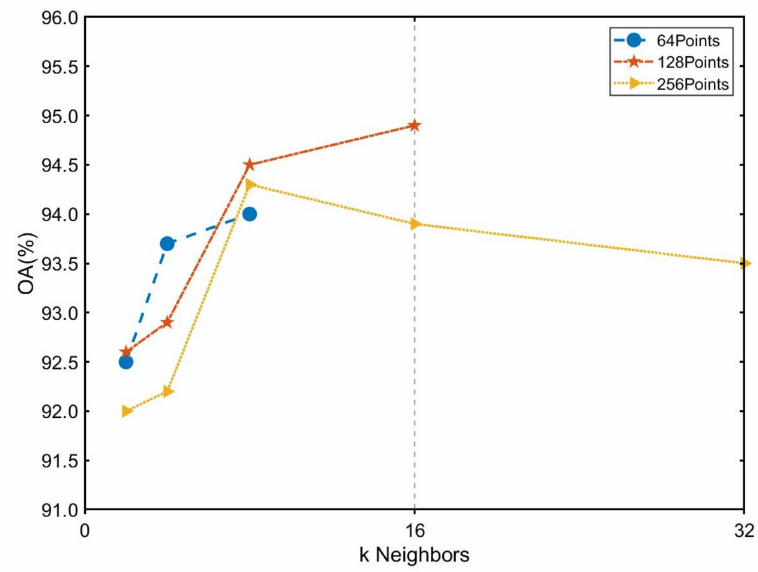
Figure 11. The influence of the number of input radar points and